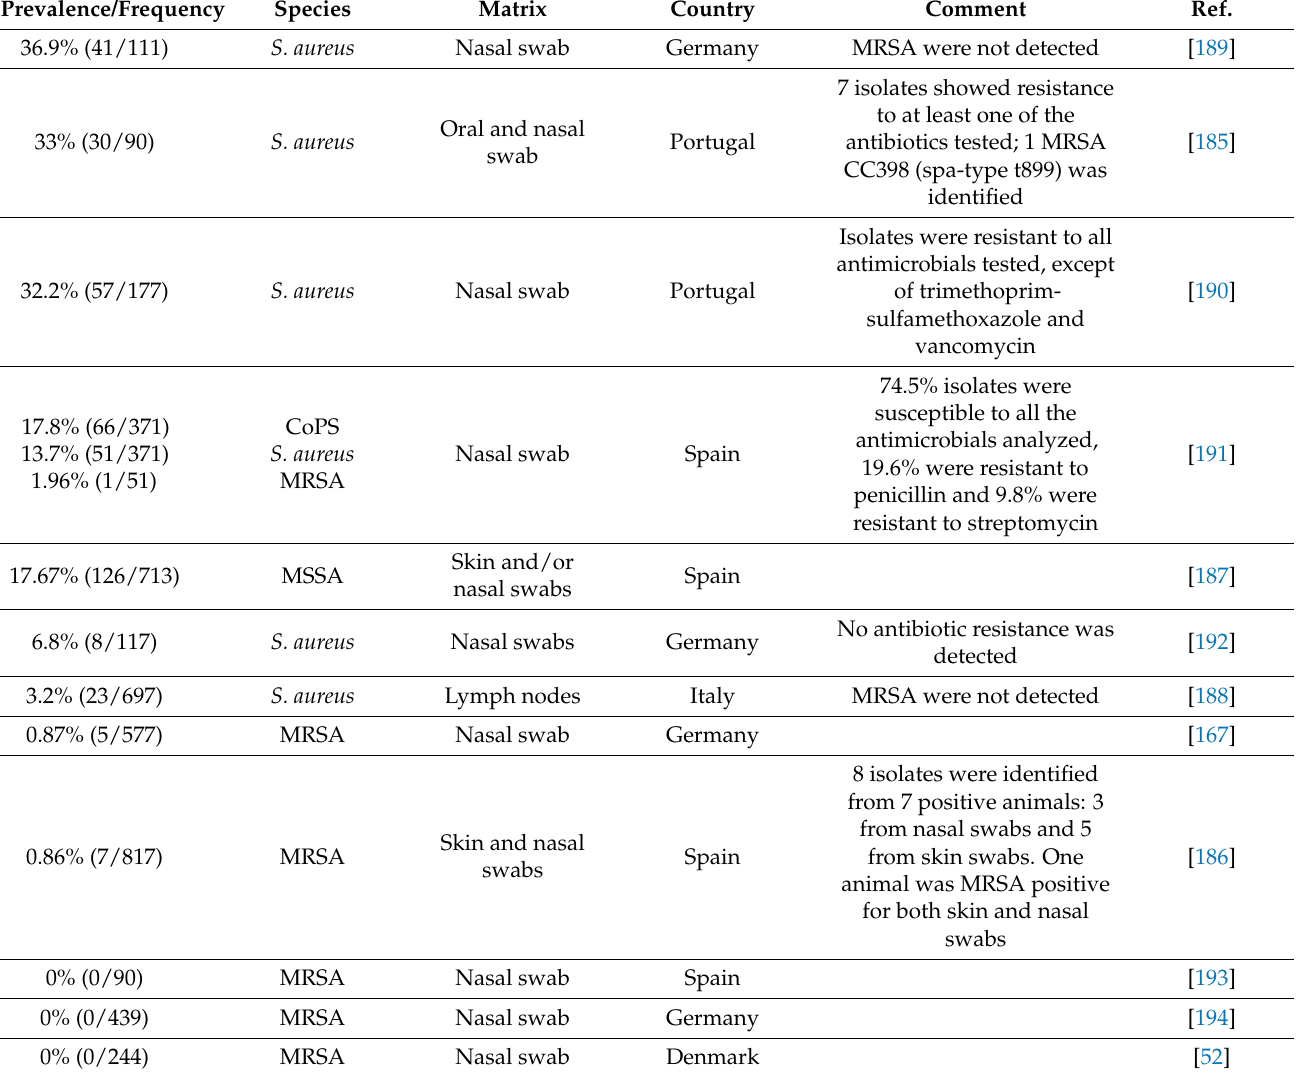
Table 11. Prevalence of MRSA on wild boar mucosal membranes and in lymphatic organs,